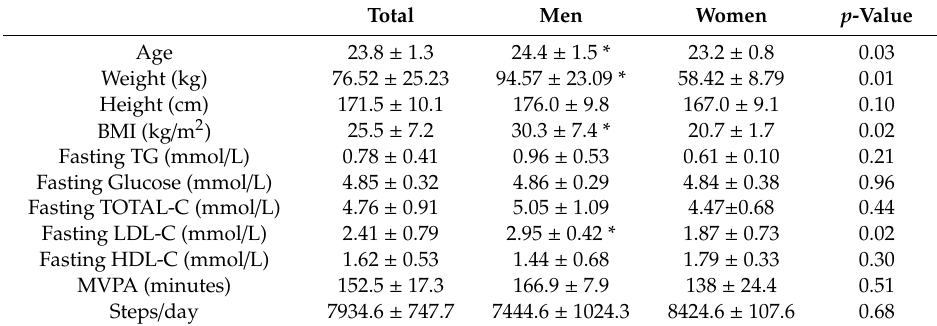
Table 2. Participant characteristics. Metabolic outcomes represent fasting data averaged across the four meal trials.